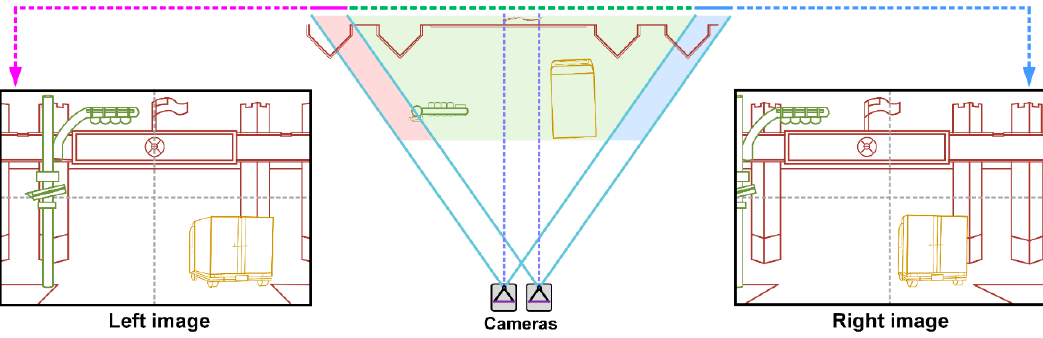
Figure 18. Different scenes are captured in stereo vision due to the visual angle difference between two cameras.